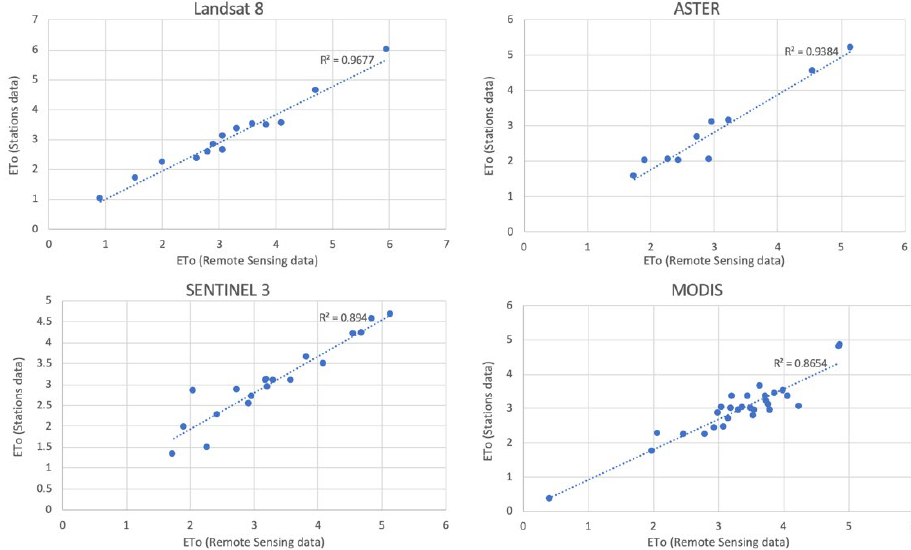
Figure 6. Comparison between remote sensing data ETo and the station data ETo.